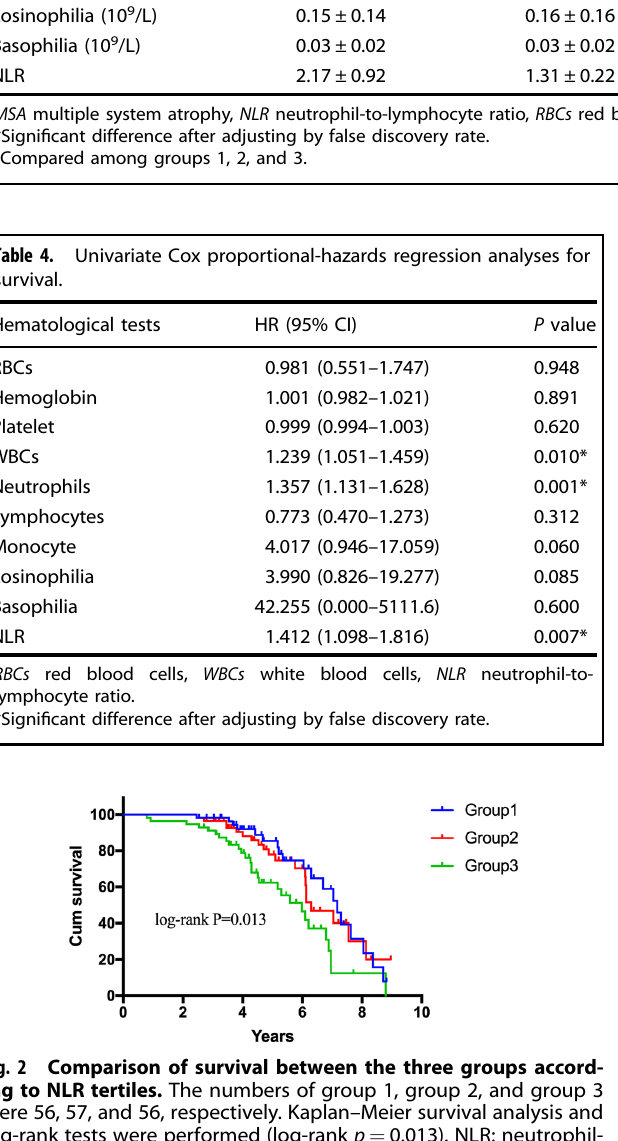
re fl ect a loss of the protective immune function of lymphocytes in MSA, as has been reported in PD 24 .